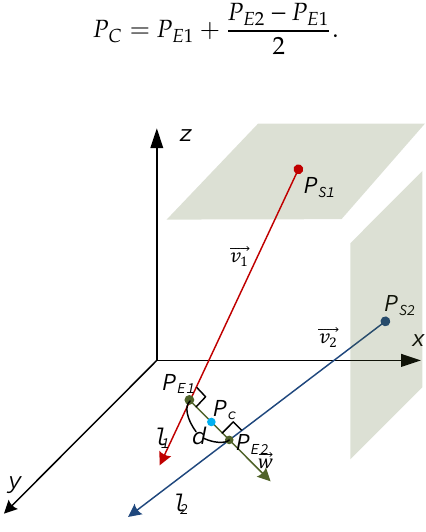
Figure 2. Geometric model to find the closest point of two vectors in a three-dimensional (3D) space.